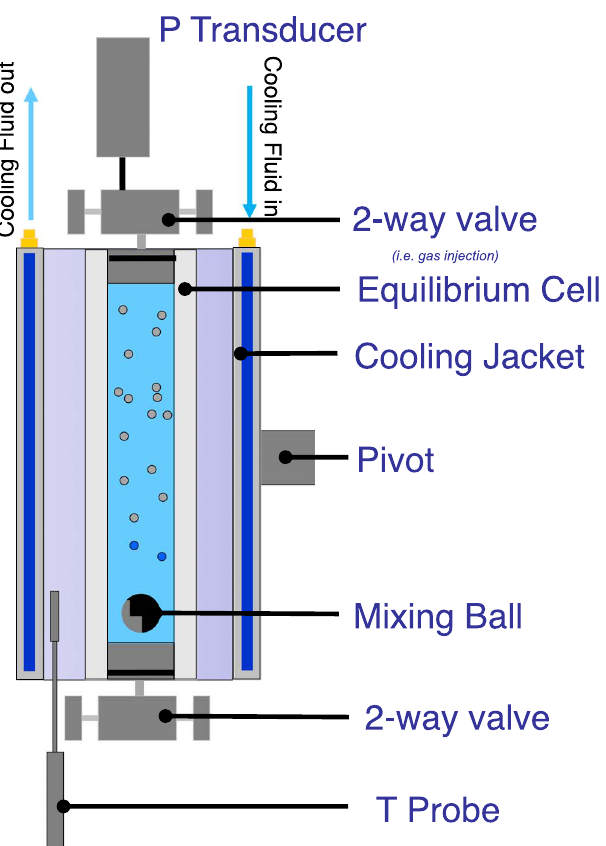
Fig. 1. Schematic of the setup used to measure the hydrate dissociation